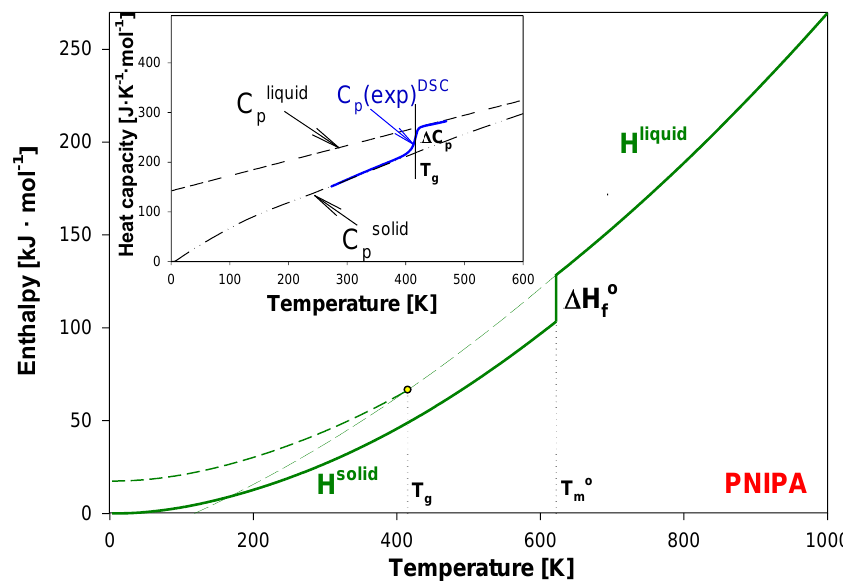
Figure 3. Enthalpy of liquid (H liquid ) and solid (H solid ) of poly( N -isopropylacrylamide) as the temperature function according to [54]. In the insert, the experimental heat capacity of poly( N -isopropylacrylamide) is presented in reference to equilibrium solid, C psolid , and liquid, C pliquid , heat capacities [54].